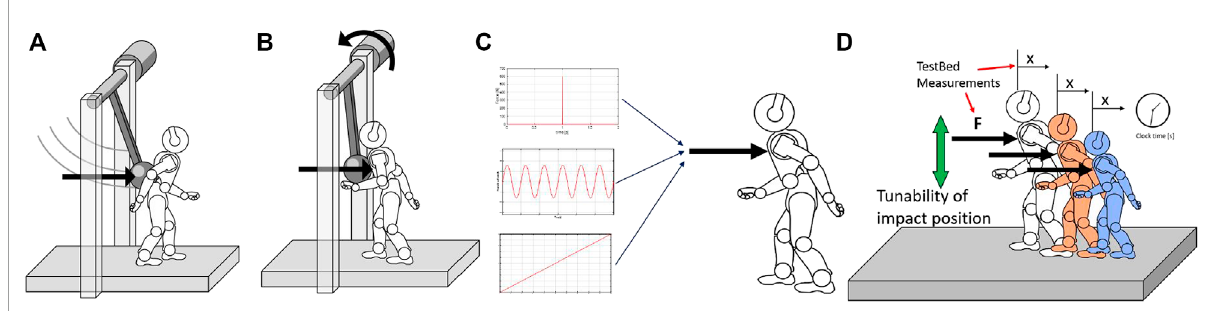
FIGURE 1 Conceptual design of the structure. (A) Represents the impulsive, highly dynamic experiments, while (B) represents the quasi-static experiments. (C) Definition of the required experiments for Performance Characterization. (D) Basic features of the testbed, to perform test on different robots. Panel (A) and (B) are taken from Monteleone et al. (2020), a previous work of the